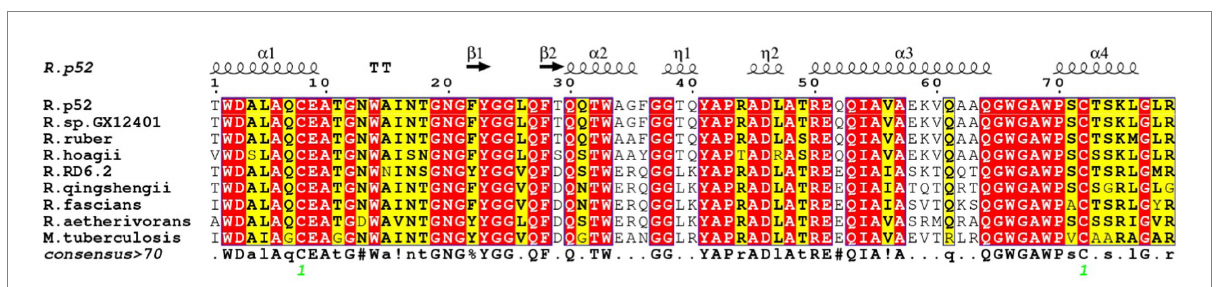
FIGURE 4 Alignment of amino acids between Rhodococcus and M. tuberculosis H37Rv; the same amino acids are expressed in capital letters corresponding to amino acids; highly conserved amino acids are expressed in red text; low conserved amino acids are expressed in yellow text; amino acid sequence number: Rhodococcus sp. P52 (AOD22115.1); R. ruber (CDZ91285.1); R. hoagii (ORL28008.1); R. RD 6.2 (CRK49436.1); R. qingshengii (BCF84662.1); R. fascians (KMJ48458.1); R. aetherivorans (KDE15285.1); M. tuberculosis H37Rv